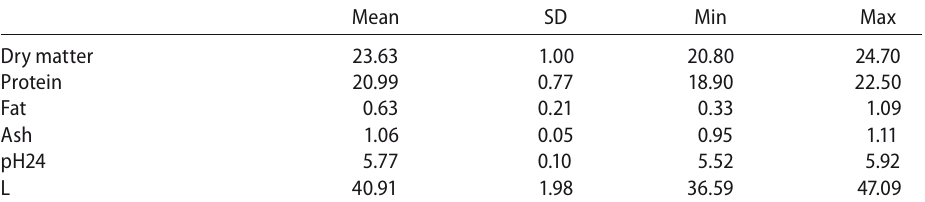
Chemical composition (%) of longissimus muscle and meat quality of male buffalo